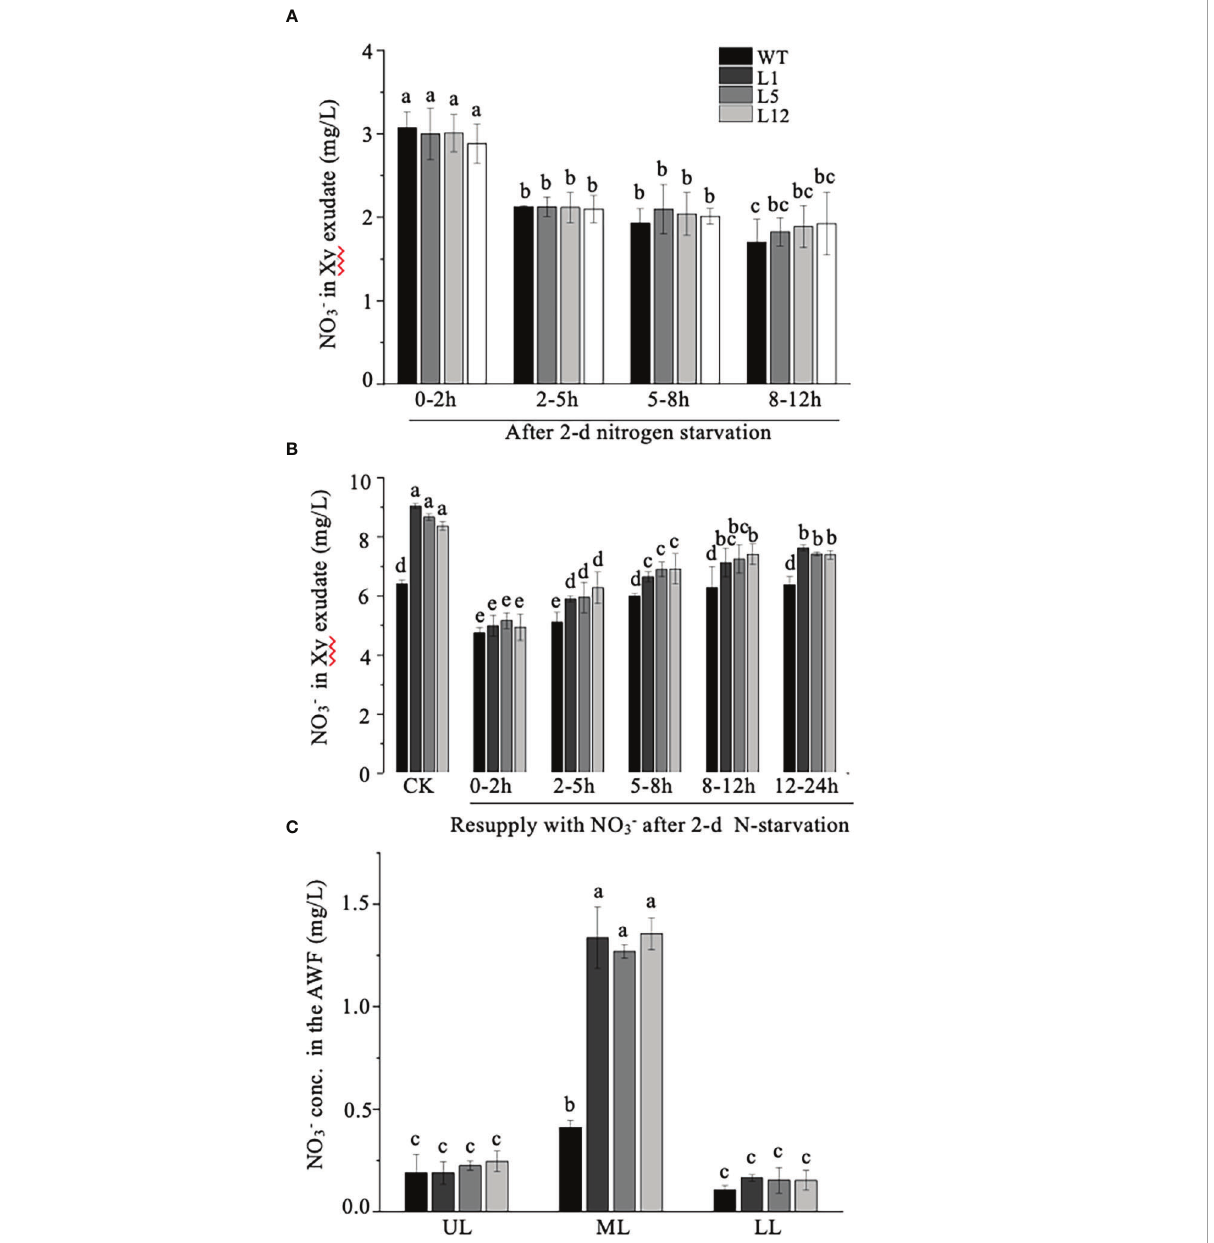
FIGURE 7 Determination of NO − 3 concentration in xylem exudate and apoplastic washing fl uid (AWF) of NtNRT1.1B -overexpressing plants and WT tobacco. (A, B) NO − 3 concentration in the xylem exudate. After 4 weeks of hydroponic pre-culture of NtNRT1.1B -overexpressing tobacco lines and their WT (K326) with the normal nutrient solution, plants were subjected to N starvation for 2 days or those resupplied with 2 mM NO − 3 after 2 days ’ N starvation were used to collect xylem exudate (see Materials and methods). The xylem exudate derived from the plants starved of N (A) or resupplied with NO − 3 after 2 days ’ N starvation (B) . Samples were collected over a 0- to 2-, 2- to 5-, 5- to 8-, 8- to 12-, or 12- to 24-h period after removal of the plant ’ s upper parts. Xy, xylem. CK, the sample collected from the plants grown with 1 mM NH 4 NO 3 as the N source and served as the control. (C) NO − 3 concentration of AWF. The AWF was extracted from different leaves of the plants grown for 4 weeks under hydroponic culture conditions (see Materials and methods). UL, ML, and LL indicate upper, middle, and lower leaf, respectively (see Materials and methods). The concentration of NO − 3 was determined using a fl ow analyzer (see Materials and methods). At least six biological replicates were conducted. The means + standard deviation (SD) ( n = 6) were plotted, and different letters indicate statistically signi fi cant differences [ P < 0.05, one-way analysis of variance